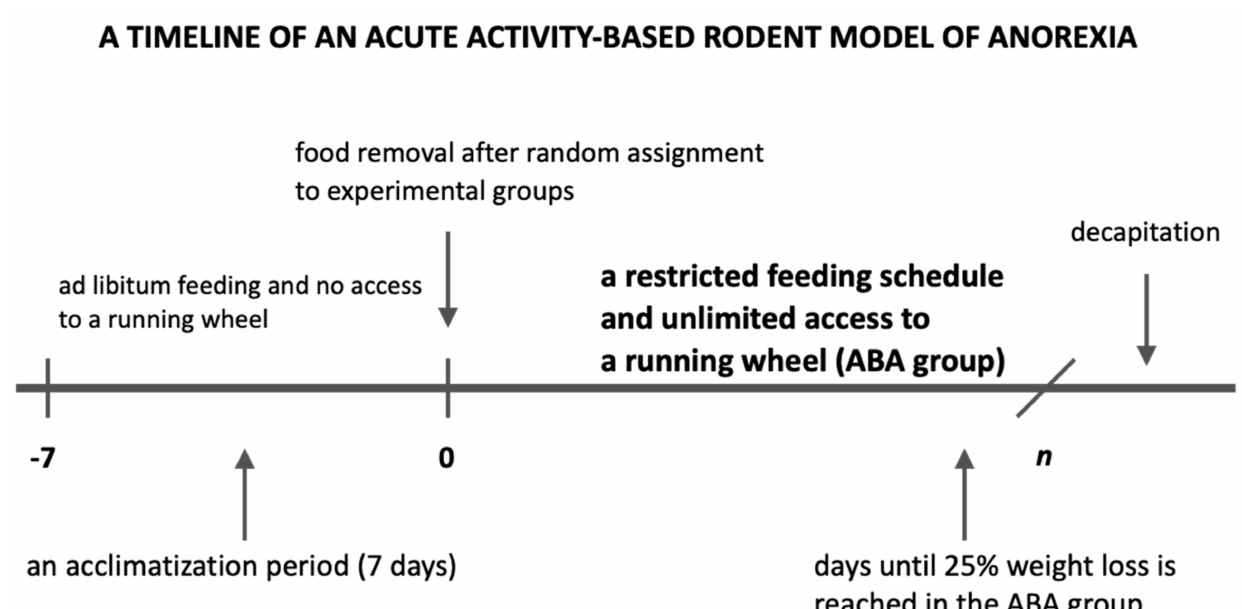
Figure 1. The general timeline of the ABA protocol used in the study. n = 6 for 19 ABA rats; n = 7 for 23 ABA rats ( n = days until